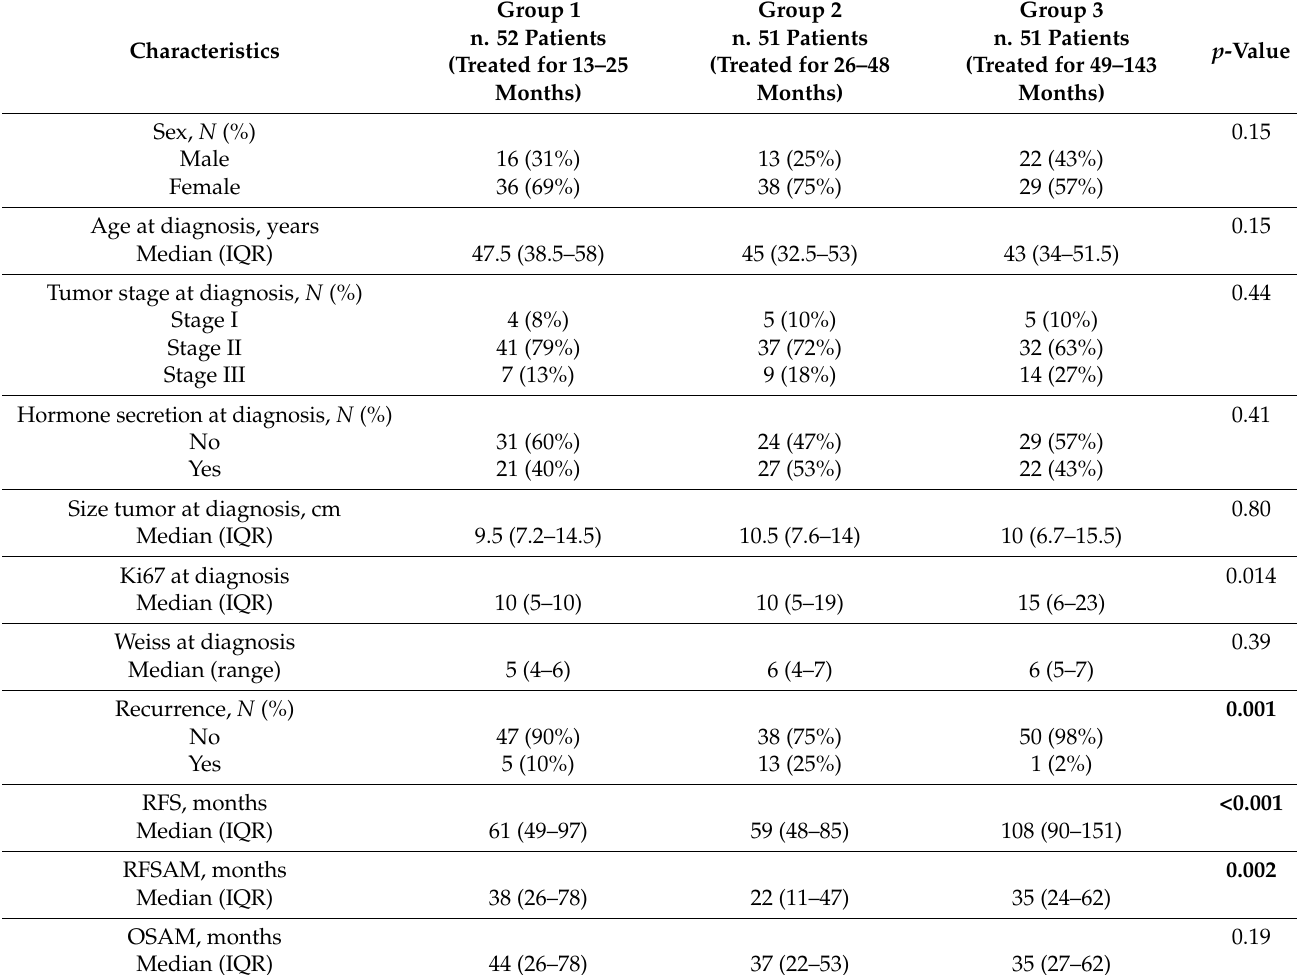
Table 2. Baseline characteristics of patients in different groups stratified by duration of therapy.